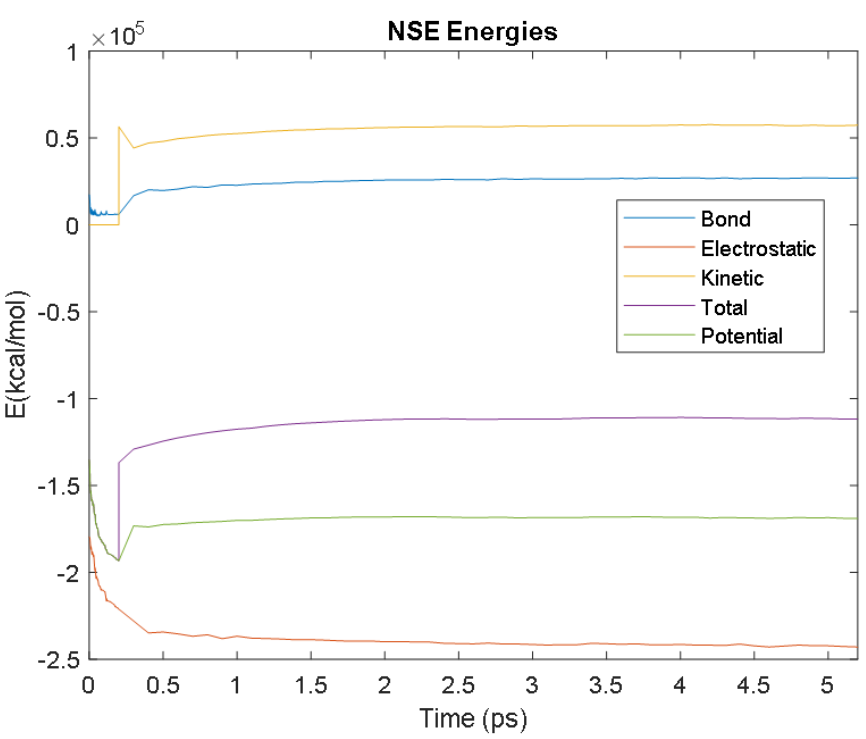
Figure 28. A plot of NSE’s bond, electrostatic, kinetic, total, and potential energies.